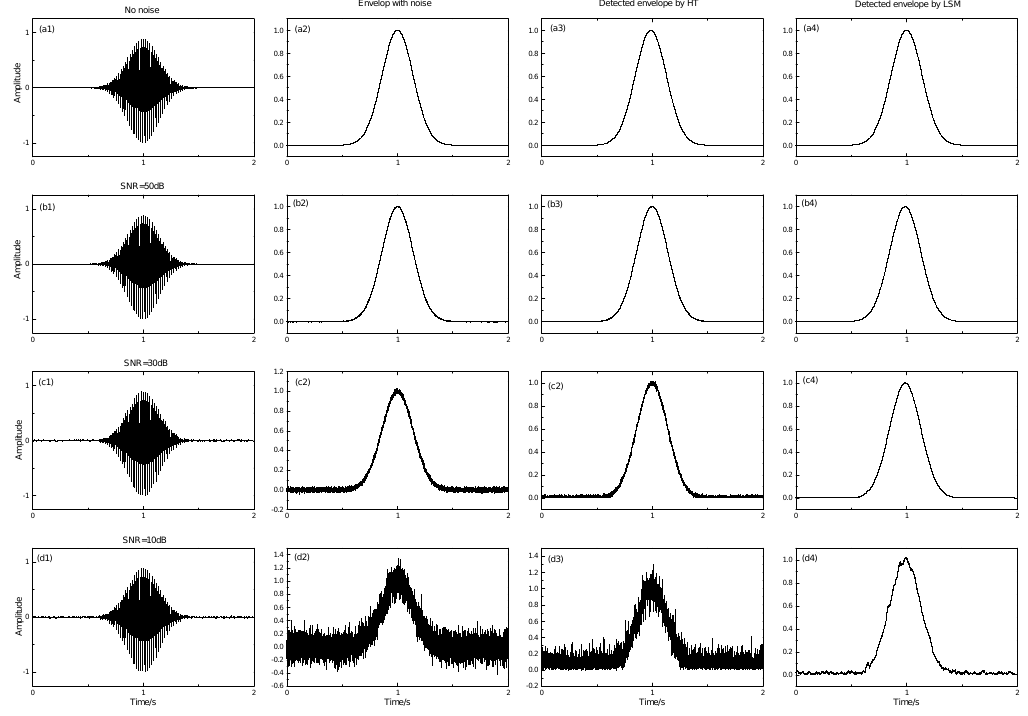
Figure 10. The comparison for envelope detection based on the Hilbert transform (HT) and least squares method